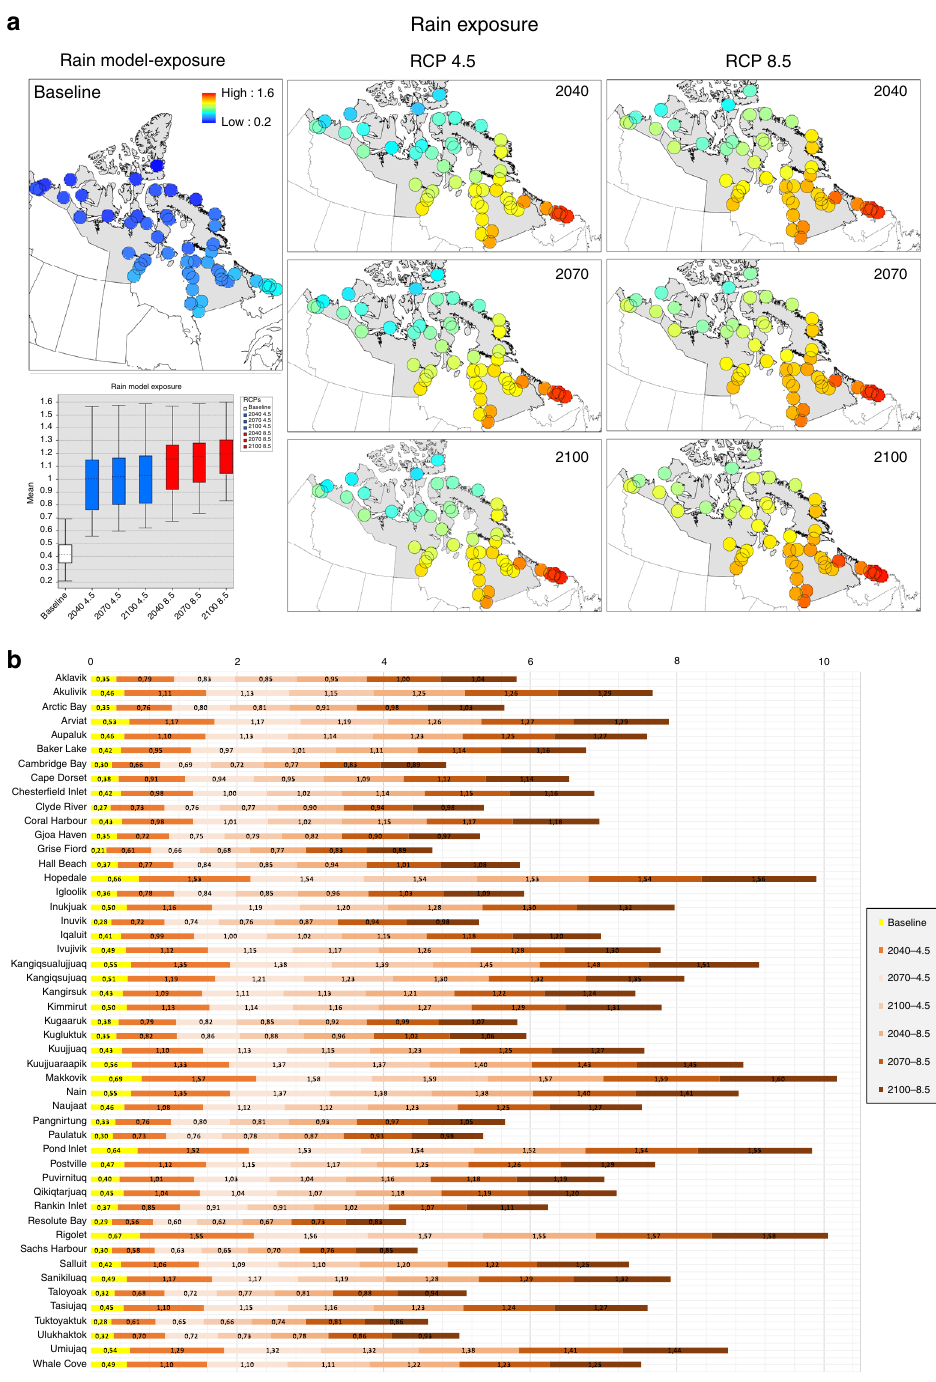
Fig. 3 Exposure maps. a Rain exposure maps. Rain exposure model for 49 Inuit Nunangat communities including baseline and future RCP 4.5 – 8.5 scenarios (2040, 2070, 2100). Boxplot includes baseline and RCP 4.5 (blue) and RCP 8.5 (red) scenarios mean values, max-min values and outliers (when applicable). The boxplot x -axis represents the baseline and the subsequent scenarios and the y -axis the mean exposure values. The community of Quaqtaq was not included in the rain and snow models due to unavailability of physical features for its entire buffer. b Communities rain exposure graph. Accumulative rain model exposure for 49 communities including baseline and future scenarios for the multiplicative equation. Yellow bars represent baseline period and orange gradient bars delimit RCP 4.5 and 8.5 future scenarios. The community of Quaqtaq was not included in the rain and snow models due to unavailability of physical features for its entire model, are distributed across the Central Arctic and Kivalliq region. This was due to lower levels of high school and trade certi fi cate attainment and lower CWI scores.